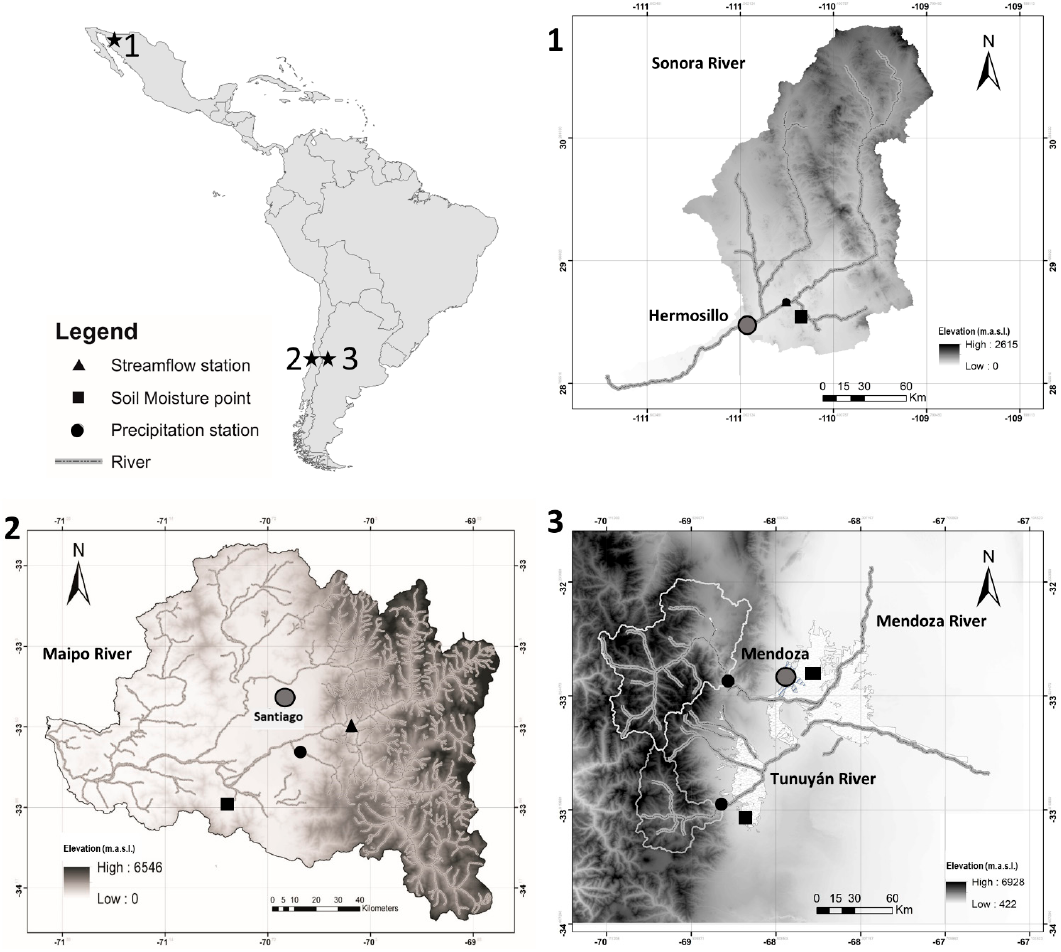
Figure 2. Maps of selected river basins: ( 1 ): Sonora, ( 2 ): Maipo, and ( 3 ): Mendoza-Tunuyán.